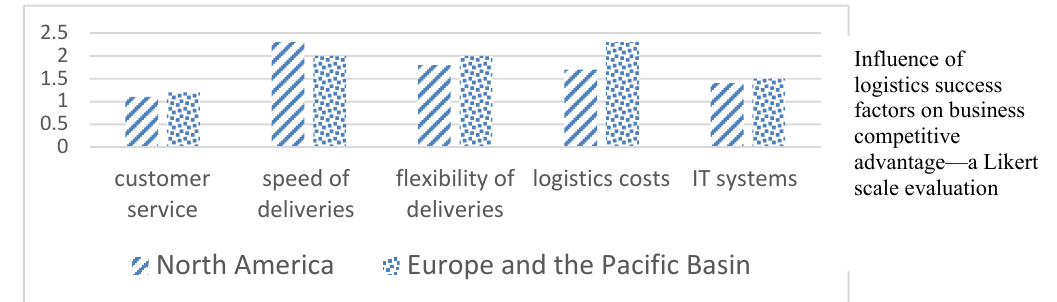
Figure 1. The influence of specific logistics success factors on business competitive advantage in North America, Europe, and in the Pacific Basin.